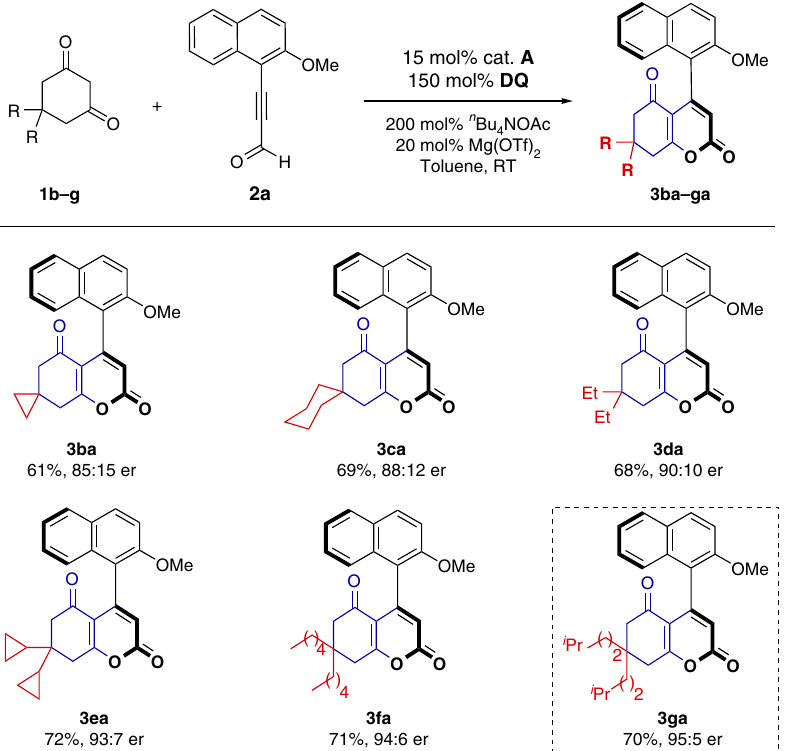
Fig. 2 Scope of cyclic 1,3-diones. Reaction conditions: a mixture of 1b – g (0.11 mmol), 2a (0.10 mmol), n Bu 4 NOAc (0.2 mmol), oxidant E (0.15 mmol), Mg (OTf) 2 (20 mol%), and cat. A (15 mol%) in toluene (2.0 mL) was stirred at room temperature under N 2 for 24 h